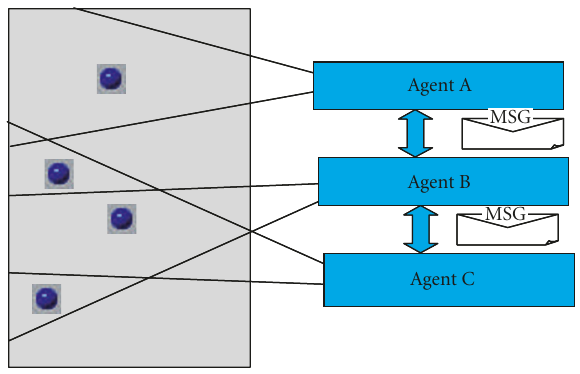
Figure 5: Overview of camera agents exchanging